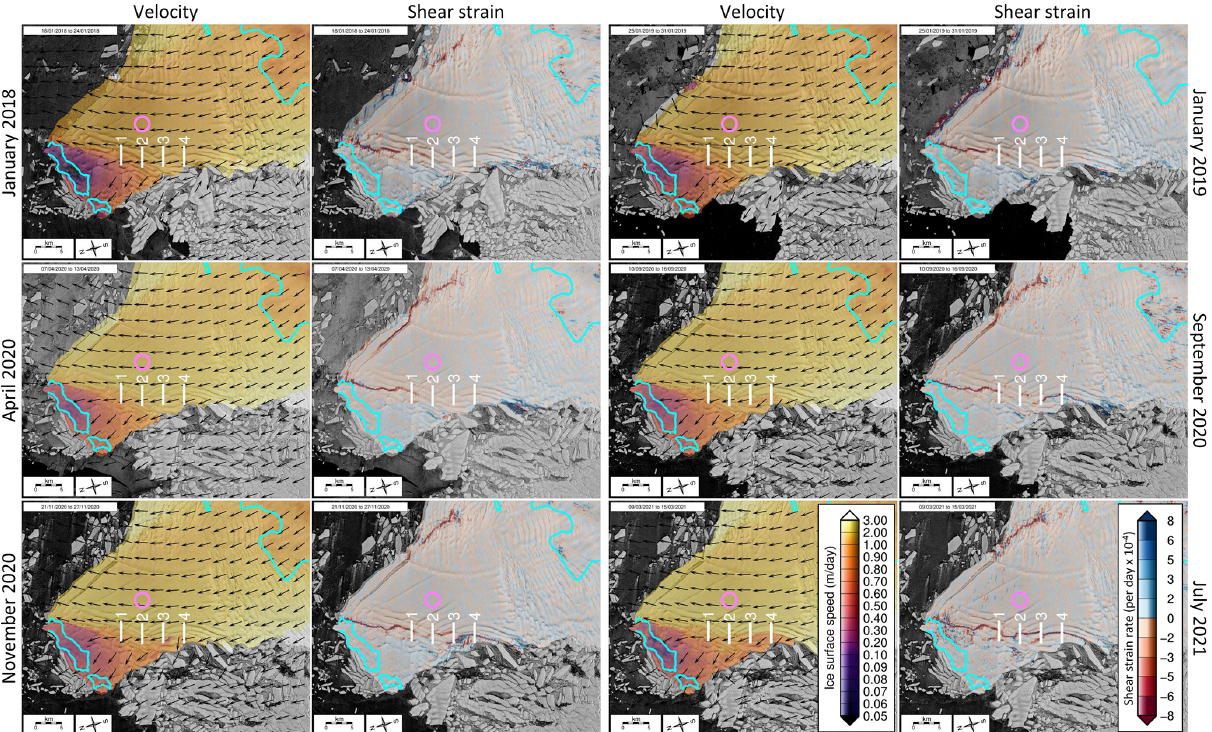
Figure 4. Evolution of velocity (first and third columns) and shear strain rate (second and fourth columns) on TEIS derived from Sentinel-1 speckle tracking between 2016 and 2021. Specific image pairs are chosen for excellent coherence and minimal noise, and to focus on recent months. Cyan lines are MEaSUREs InSAR-derived grounding lines from 2011 showing the location of historic known pinning points. White lines show positions of numbered profiles used to extract velocities presented in Fig. 5. The magenta circle indicates the location of the velocity time series shown in Fig.